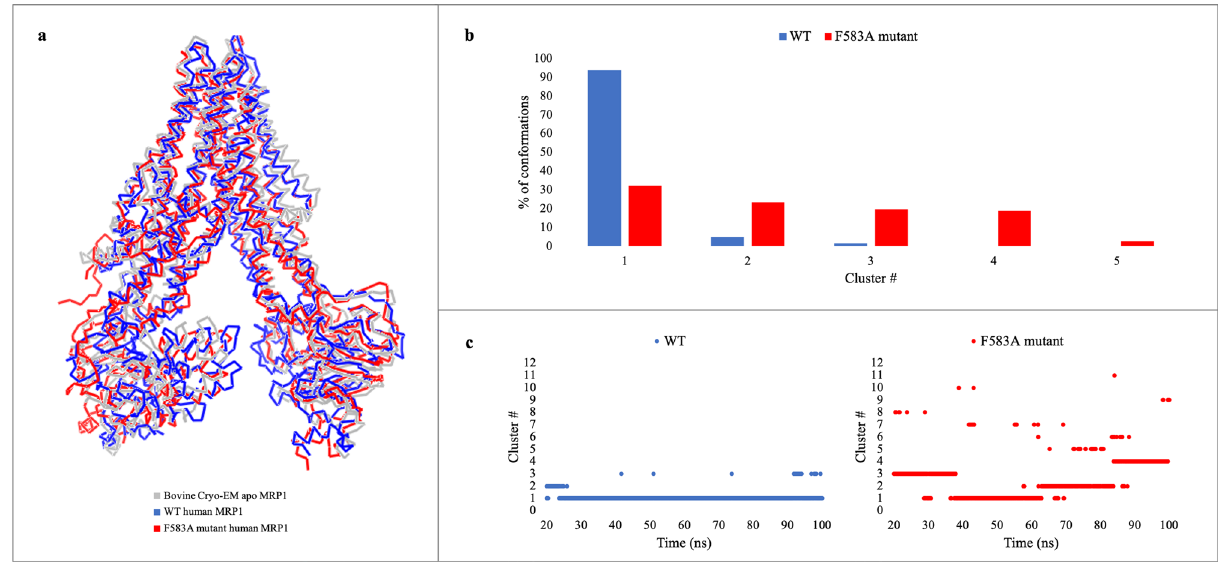
Figure 2. Cluster analysis of the WT (blue) and F583A mutant (red) simulations. (a) Superposition of the bovine cryo-EM apo structure (gray), and the representative conformation (cluster #1) of the WT and F583A mutant. (b) The percentage of conformations (from all the conformations) in each cluster was calculated. (c) Cluster number in a relation to the simulation time, in representative WT and F583A mutant